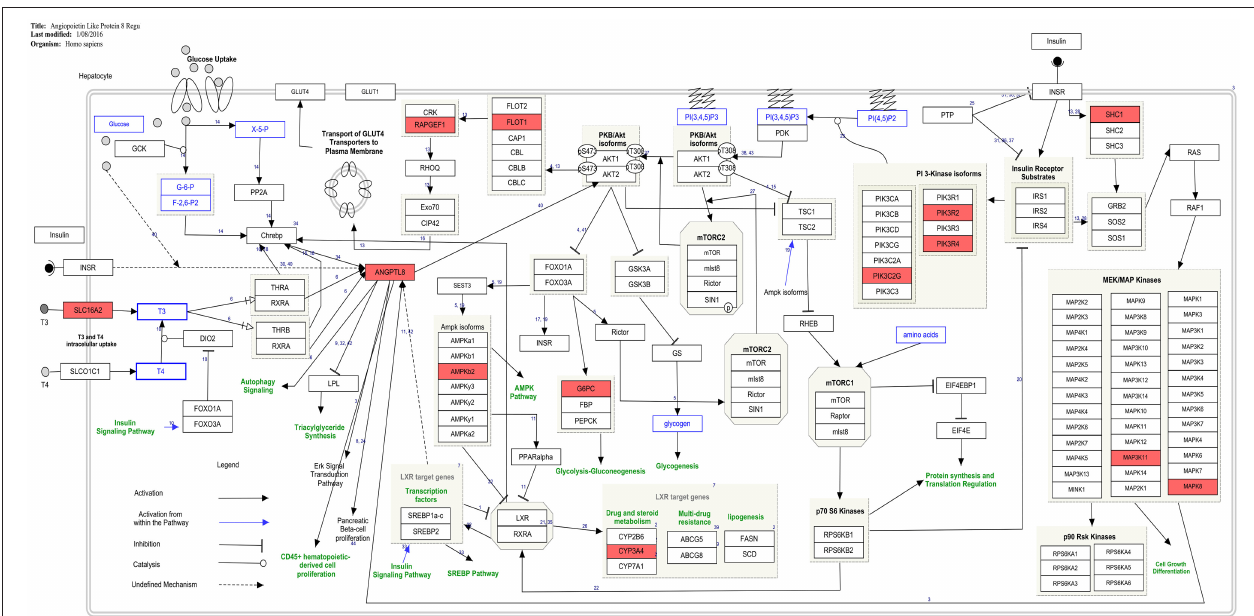
FIGURE 4 | Presence of co-expressed genes of ANGPTL8 in the ANGPTL8 Regulatory Pathway (pathway id:WP3915 (www.wikipathways.org/instance/WP3915)). Thirteen genes in the ANGPTL8 regulatory pathway which are also identified to be co-expressed with it are marked with red color. These genes (MAPK8, CYP3A4, PIK3R2, PIK3R4, PRKAB2, ANGPTL8, G6PC, MAP3K11, FLOT1, PIK3C2G, SHC1, SLC16A2, RAPGEF1) belong to different signaling arms of the pathway. Among these genes, SHC1 and PIK3C2G are also identified as hub genes.